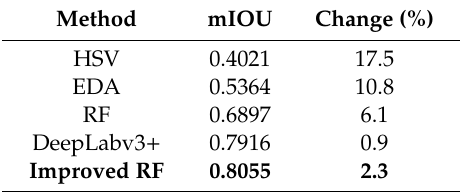
Table 5. mIOU scores for di ff erent methods applied to the original training and validation datasets.